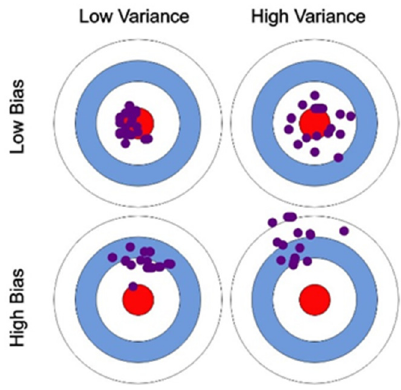
Figure 1. Bias vs. variance